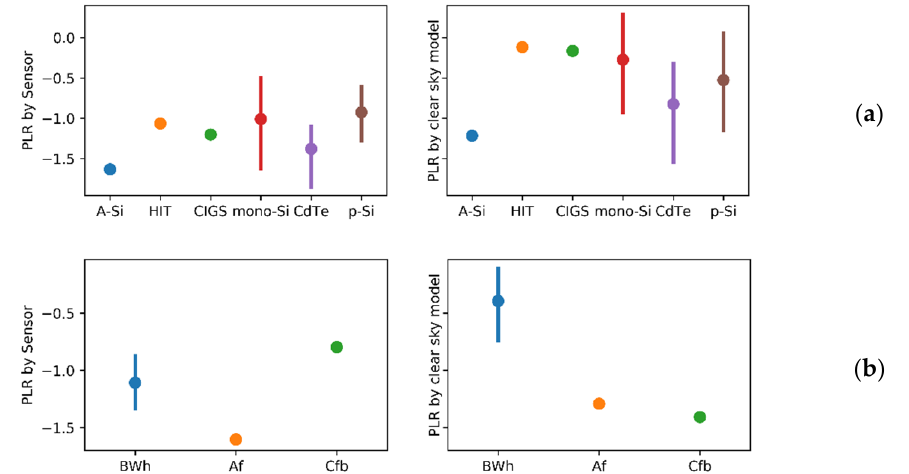
Figure 10. Performance loss rate of the PV systems using YoY. ( a ) Grouped by module technologies, ( b ) grouped by climate. Left: based on monitoring sensors, right: based on the clear sky model.